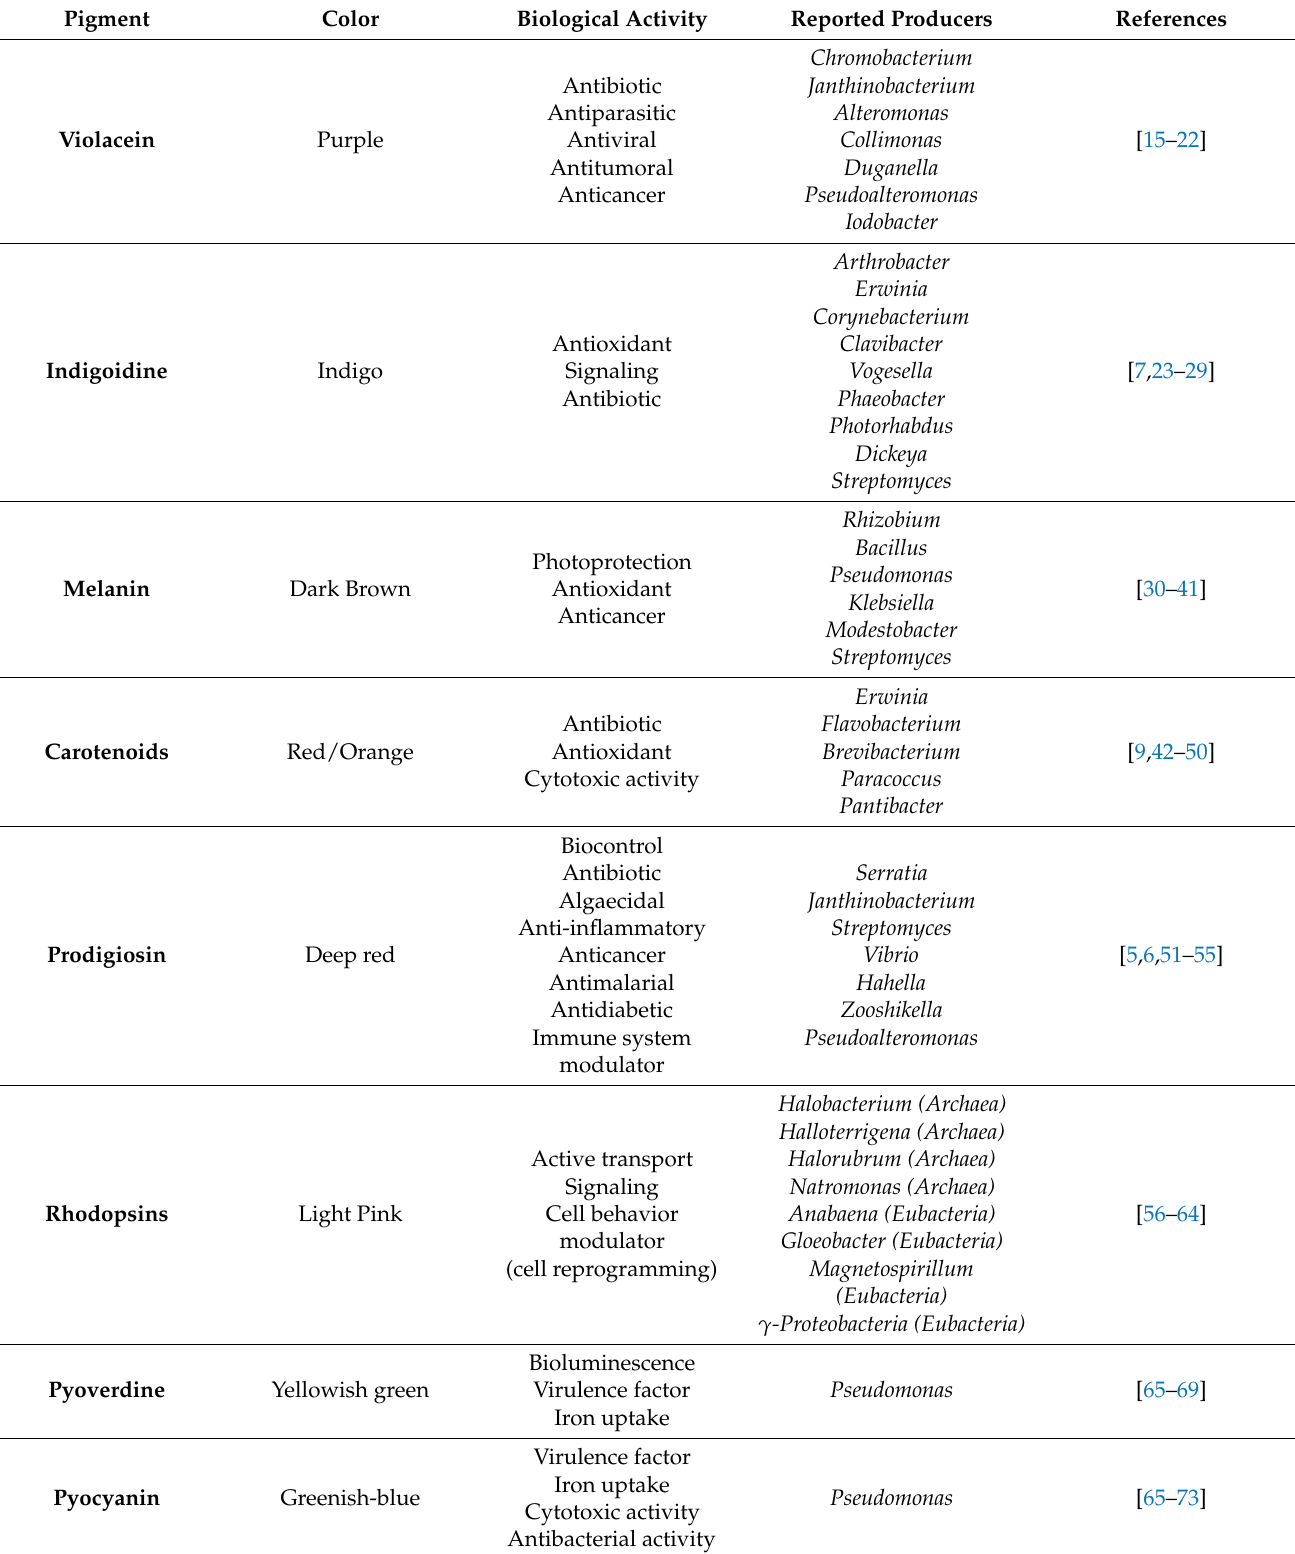
Table 1. List of all bacterial pigments reviewed, their biological activities, and reported genera of pigment producers.